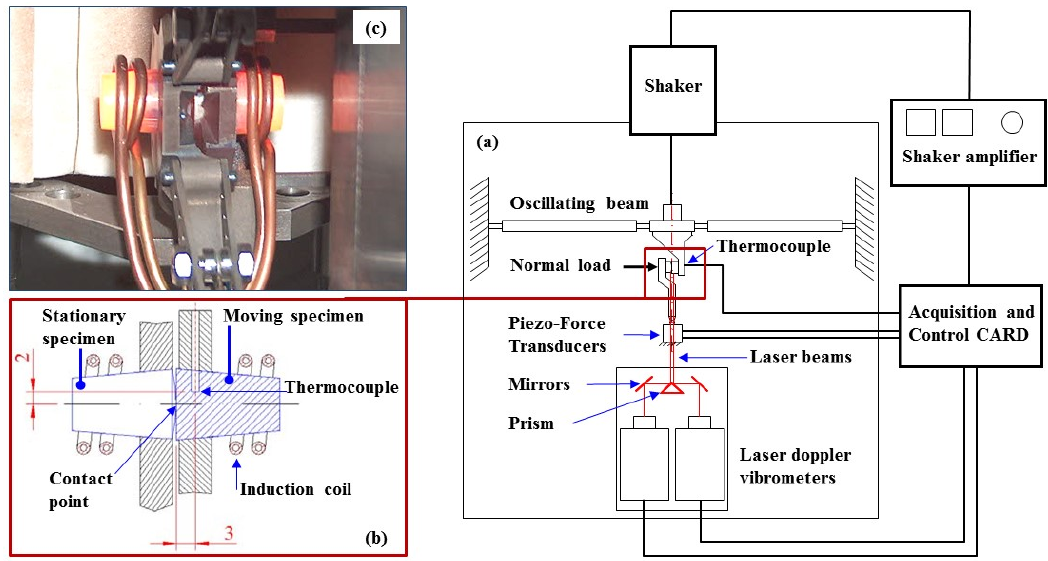
Figure 2. ( a ) Test rig scheme; ( b ) detail of samples assembling; ( c ) picture of samples in work